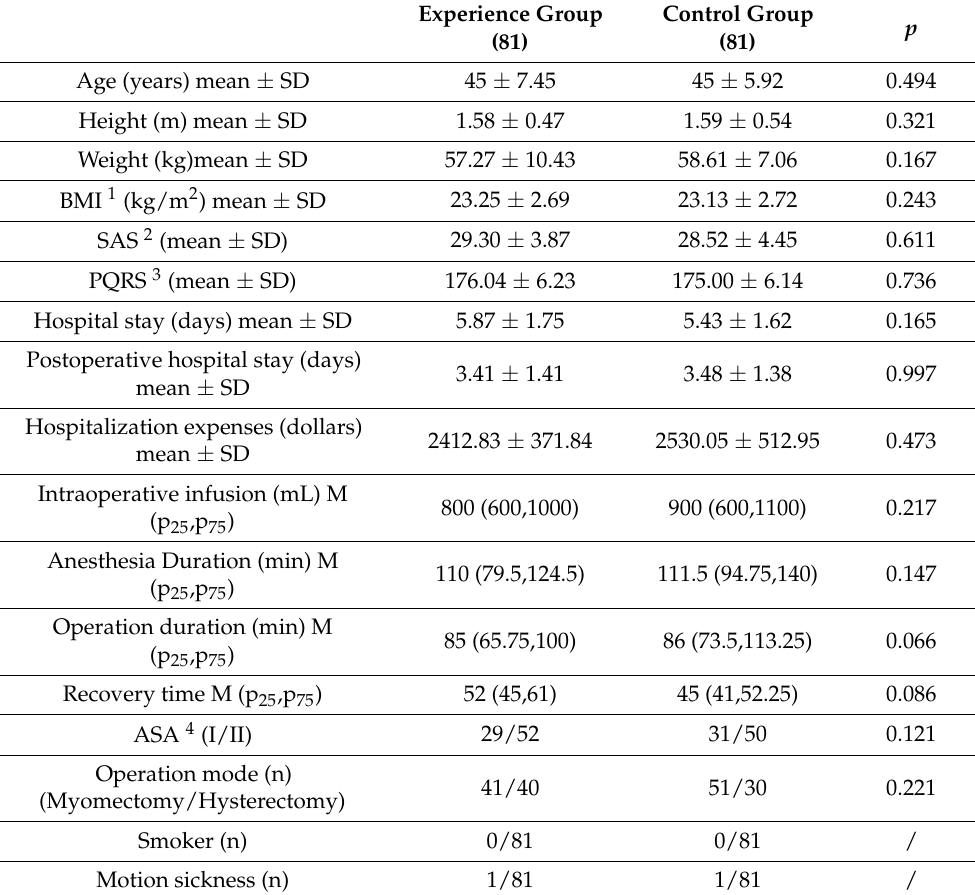
Table 1. Patient baseline characteristics and perioperative variables.